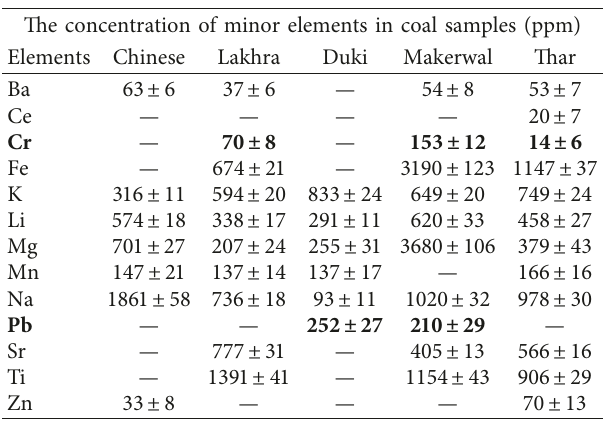
Figure 6: Elemental concentration of Makerwal coal showing both major and minor elements, the inset shows the concentration of trace metals detected in coal.